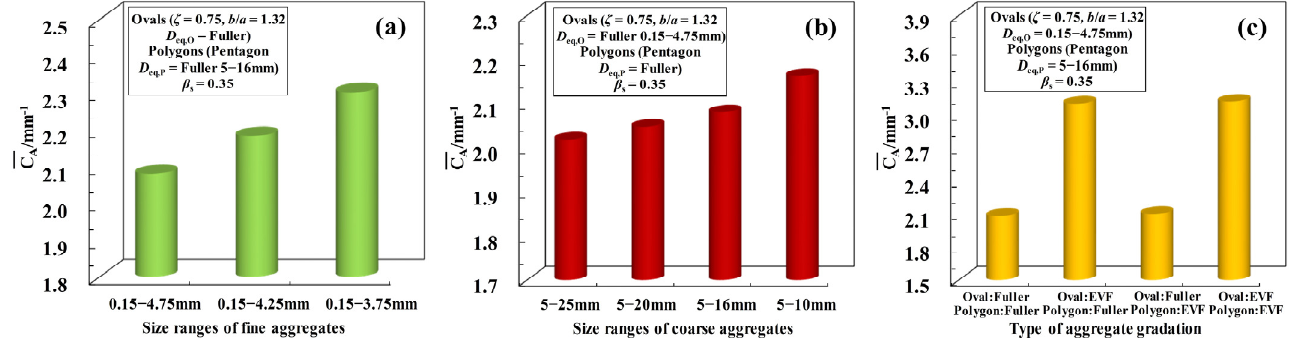
Figure 11. Comparisons of the average specific surface areas of aggregate particles for all the cases: ( a ) The curves in Figure 10a; ( b ) The curves in Figure 10b; ( c ) The curves in Figure 10c.